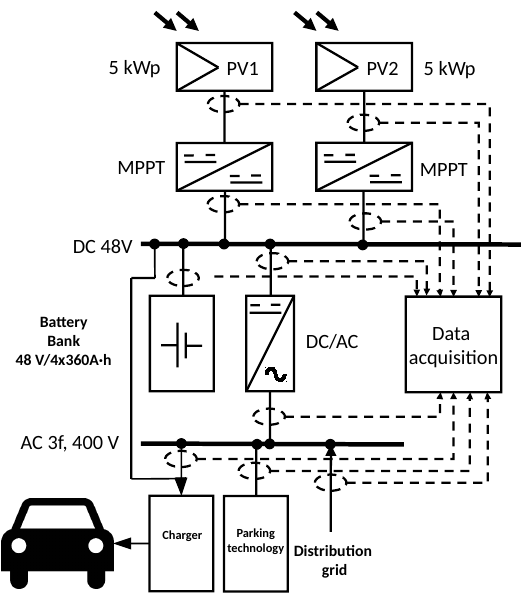
Figure 2. Scheme of the automated parking